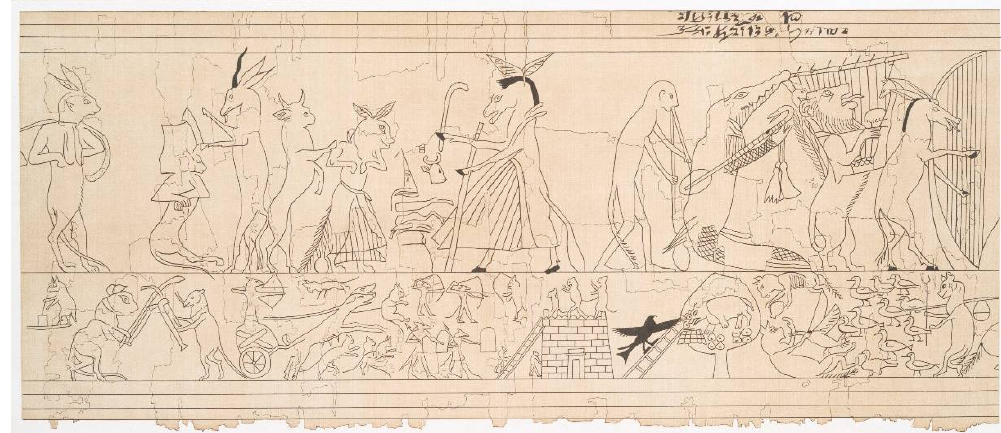
Figure 15. Reconstruction of part of the animal section of the Turin Papyrus 55001 (CME inv. no. c.2031) (Taken from Émile Prisse d’Avennes, Histoire de l’art égyptien (Paris: Bertrand, 1878), pl. 78; image courtesy of the New York Public Library).